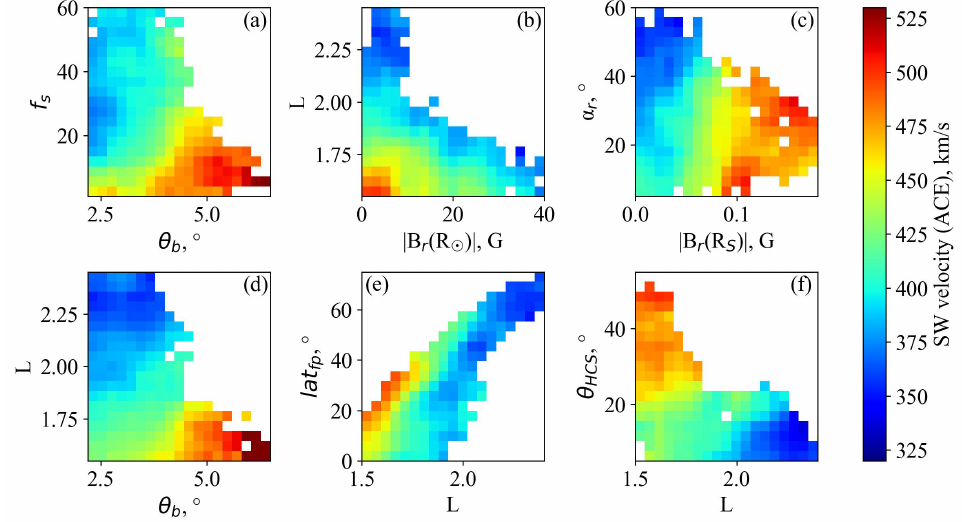
Figure 3. Relationships between different pairs of magnetic field parameters calculated from magne- tograph STOP data (2014–2022) and observed SW velocity V according to the ACE data: ( a ) V ( θ b , f S ) ; ( b ) V ( | B r ( R (cid:12) ) | , L ) ; ( c ) V ( | B r ( R S ) | , α r ) ; ( d ) V ( θ b , L ) ; ( e ) V ( L , lat fp ) ; ( f ) V ( L , θ HCS )